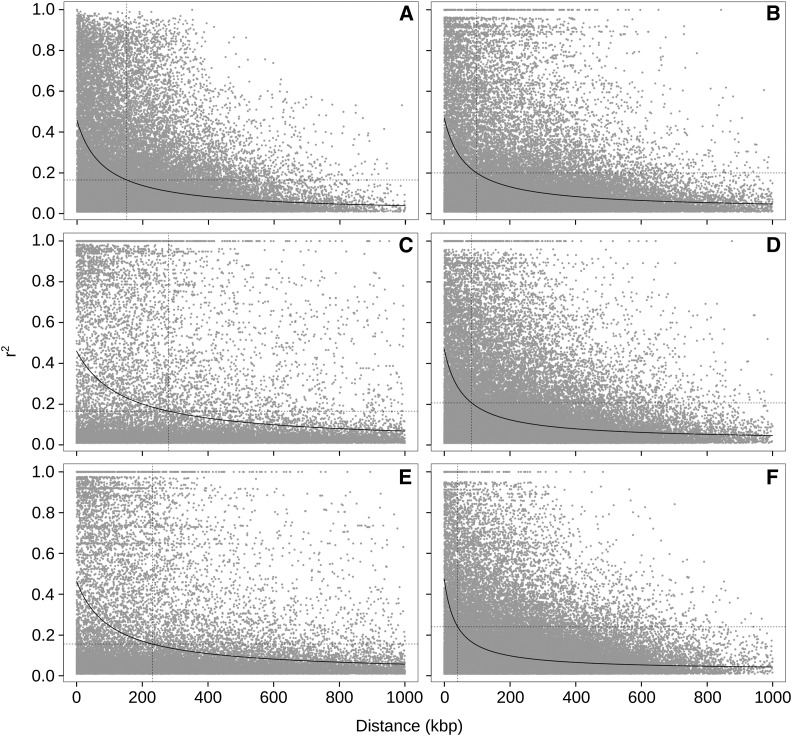
LD decay in the whole population (A) and clusters 1–5 (B–F). The dashed horizontal line indicates the average background LD of all chromosomes of a respective population. The dashed vertical line indicates the maximum distance between linked markers and is used as reference point for the LD decay.